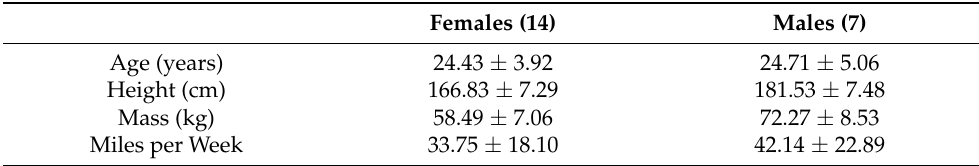
Table 1. Participant characteristics (mean ± standard